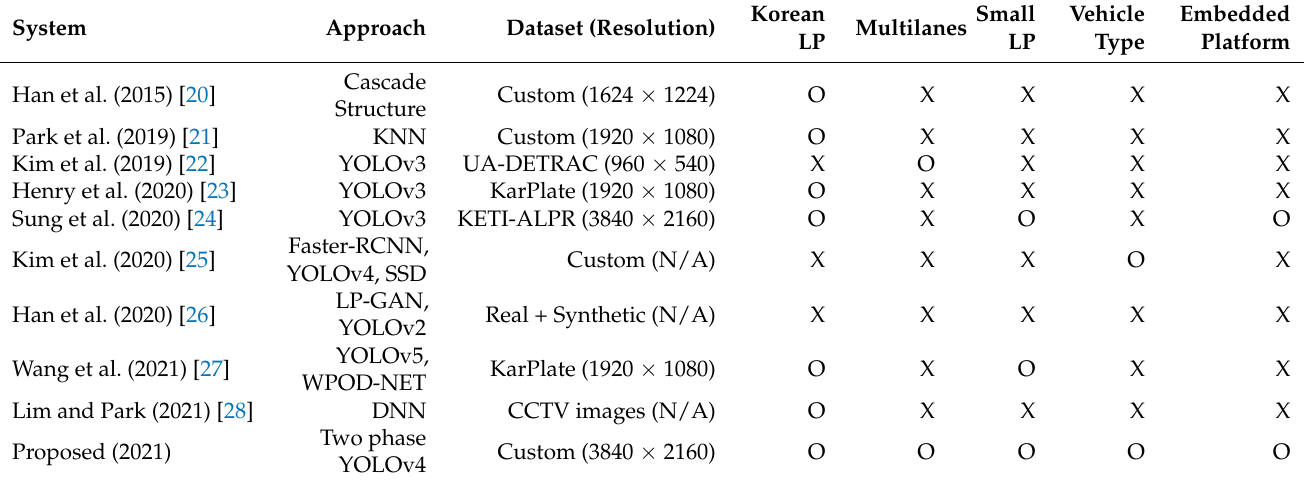
Table 1. Comparison of recent Korean LPR